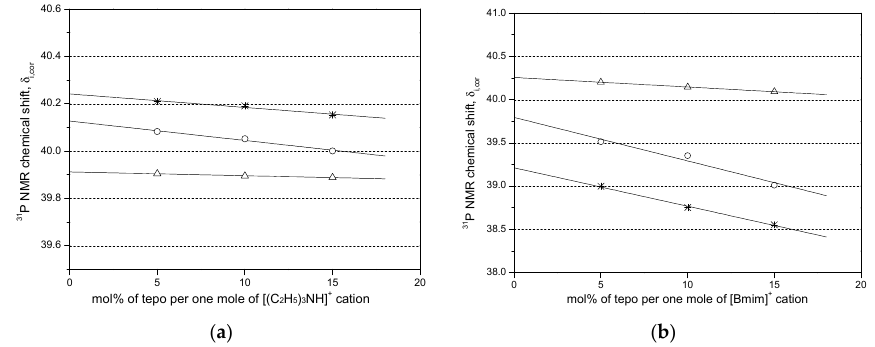
Figure 1. Experimental 31 P NMR chemical shifts for tepo as a function of tepo concentration in chloroaluminate compositions: ( a ) [(C 2 H 5 ) 3 NH] + − based ILs, [(C 2 H 5 ) 3 NH]Cl − AlCl 3 ( △ ), [(C 2 H 5 ) 3 NH]Cl − AlCl 3 − CuCl ( ○ ), and [(C 2 H 5 ) 3 NH]Cl − AlCl 3 − AgCl (*); ( b ) [Bmim] + − based ionic liquids (ILs), [Bmim]Cl − AlCl 3 ( (cid:52) ), [Bmim]Cl − AlCl 3 − CuCl ( ), and [Bmim]Cl − AlCl 3 − AgCl (cid:35)